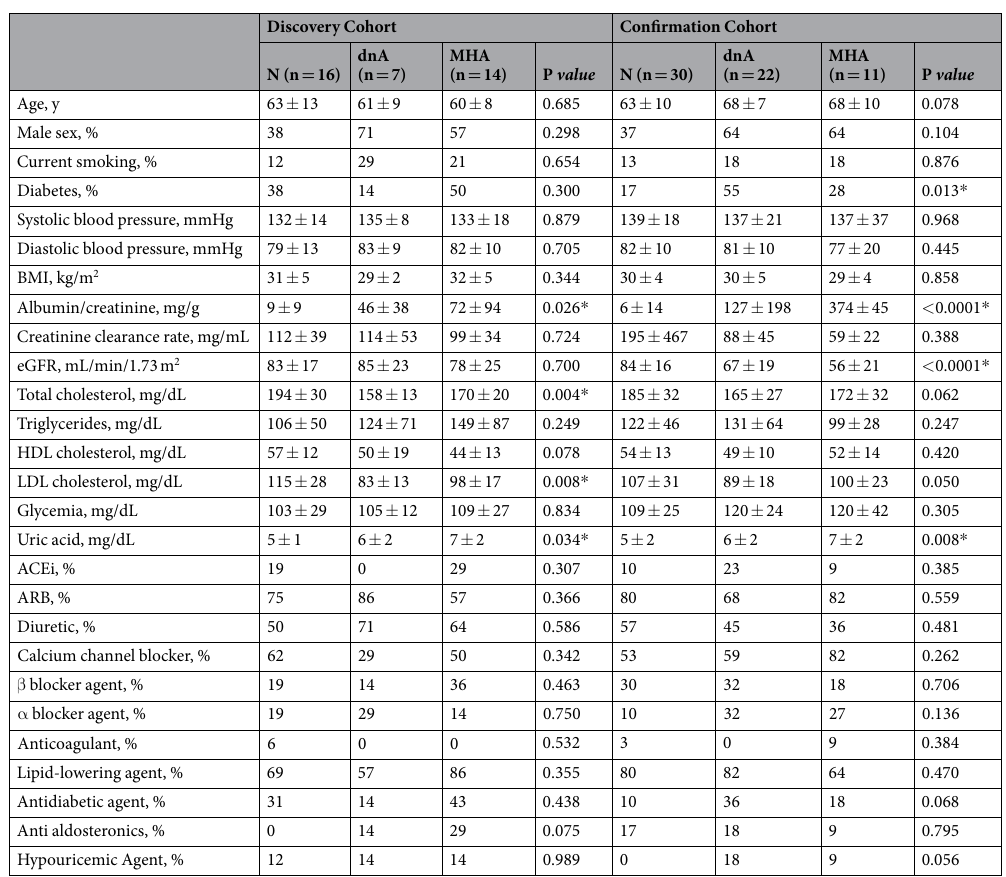
Table 3. Clinical characteristics of hypertensive patients under chronic RAS suppression included in the discovery (iTRAQ) and confirmation (SRM) cohorts. Values are expressed as mean ± SD or percentage (%). N: normoalbuminuria; dnA: de novo albuminuria; MHA: maintained high